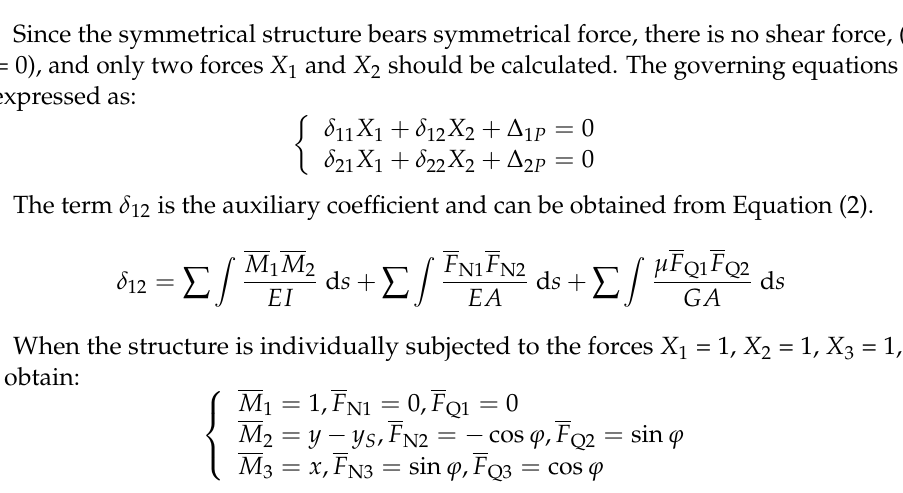
Figure 14. Schematic of the simplified model. ( a ) Coordinate system; ( b ) simplified model.